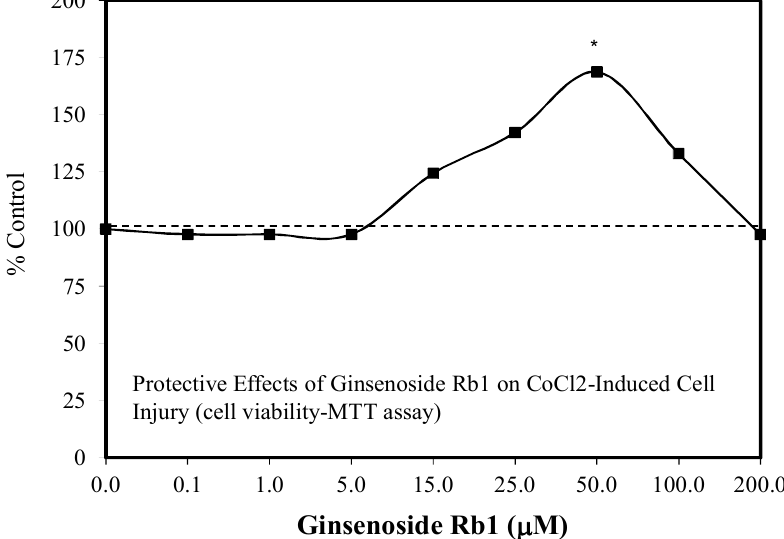
Figure 15. Protective effects of ginsenoside Rb1 on CoCl2-induced cell injury (cell viability: MTT assay) (source: [52]). Each * represent statistical significance for a data point.